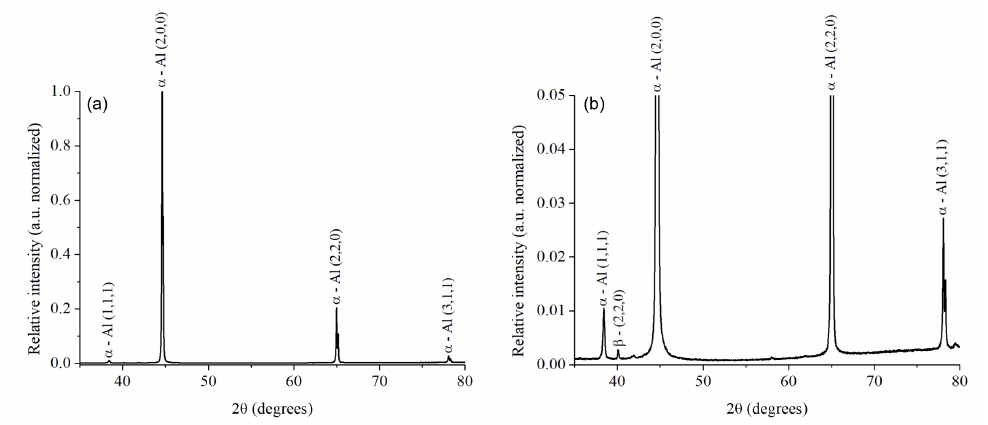
Figure 5. XRD spectra for AA6061–T4 (heat-treated) alloy at full-scale (normalized) ( a ), and the amplification of the trace peaks ( b